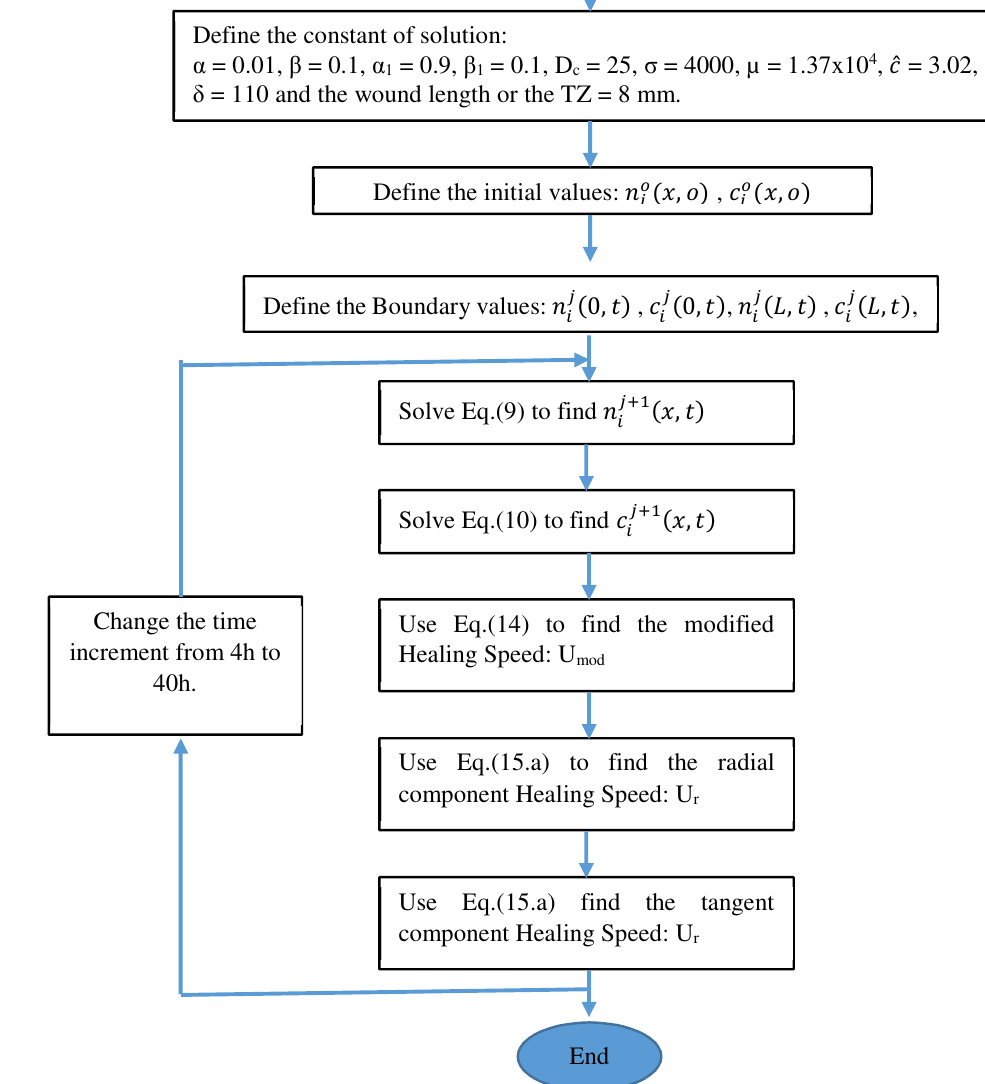
Fig. 5. Proposed solution, equations here are discussed above from point (a) to point